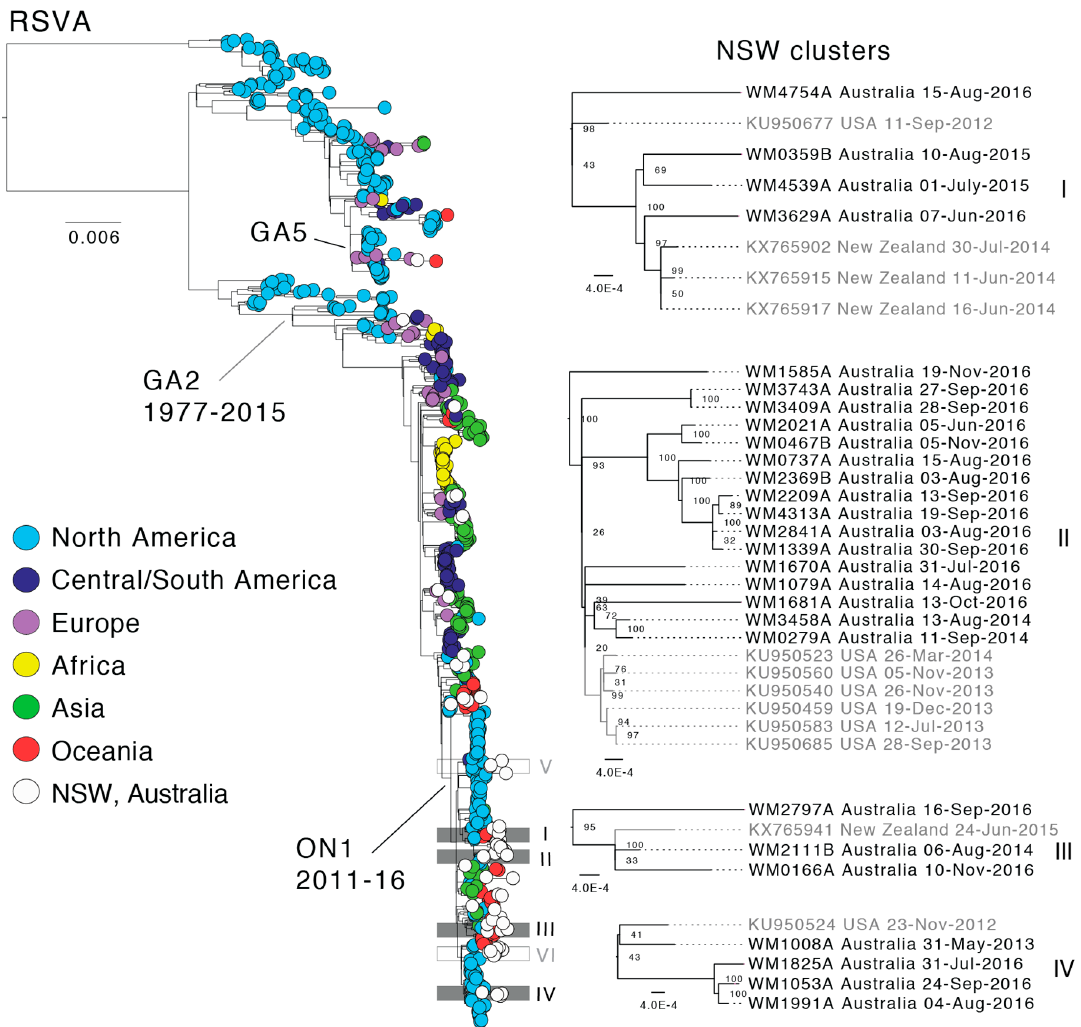
Figure 3. Global phylogeny of respiratory syncytial virus subtype A (RSVA) and local clustering within NSW. The maximum likelihood tree shown was estimated using complete RSV genome sequences. Known genotypes and the sequence time range is indicated. The tree was rooted using an RSVB outgroup. Tree tips are colored according to the geographic region and sequences from this study are shown in white. Local clusters comprising NSW sequences are marked within the global tree and the four clusters with potential multi ‐ season transmission events are colored grey and enlarged on the right side. Node supports are indicated and branch lengths are scaled according to the number of substitutions per site.